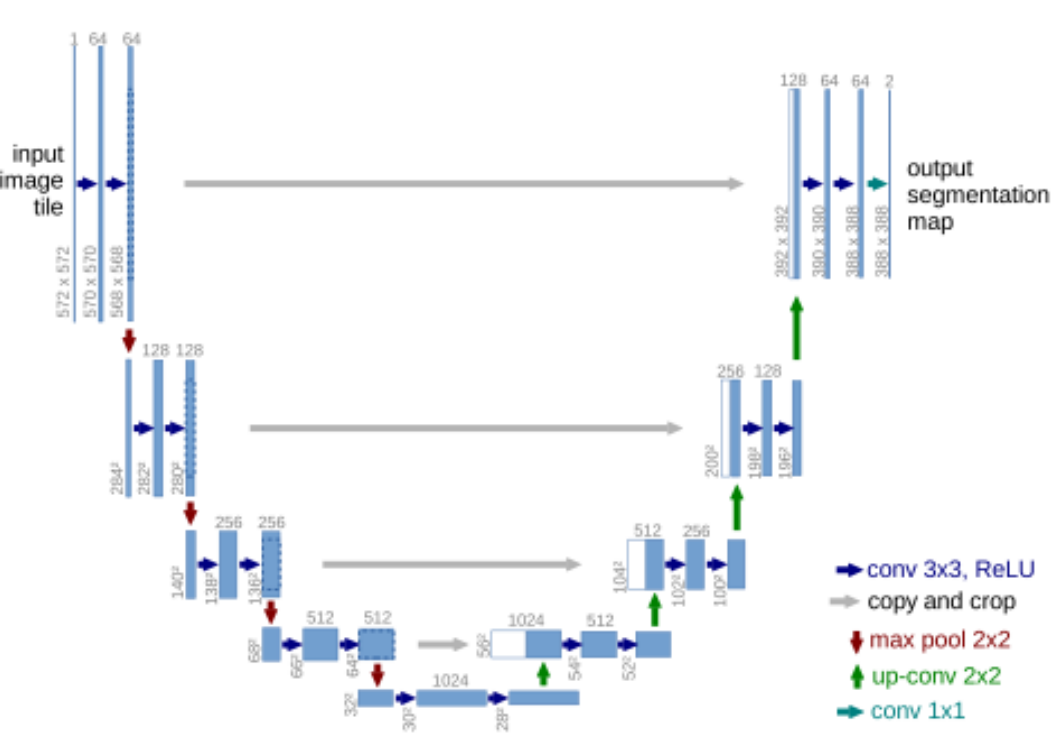
Figure 1. Illustration of the U-net from [28]. In our case, the output is not a segmentation map but a reconstructed image of the same size (we perform zero-padding to prevent decreasing sizes in